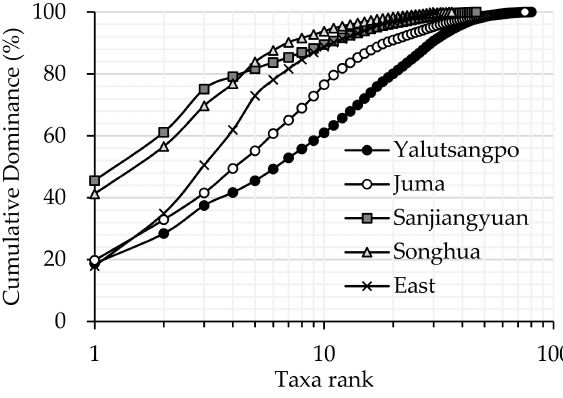
Figure 2. K-dominant curves of macroinvertebrates in the different rivers.